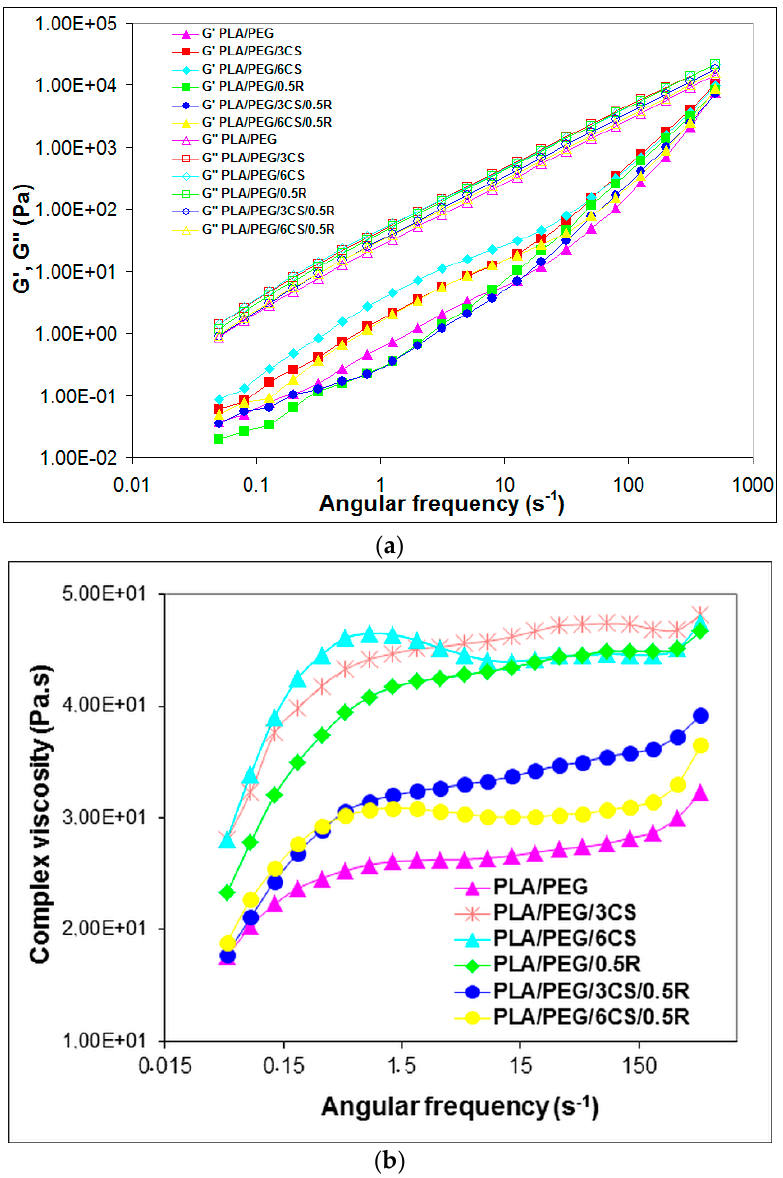
( b ) on angular frequency for PLA / PEG and PLA / PEG / CS and PLA / PEG / CS / R